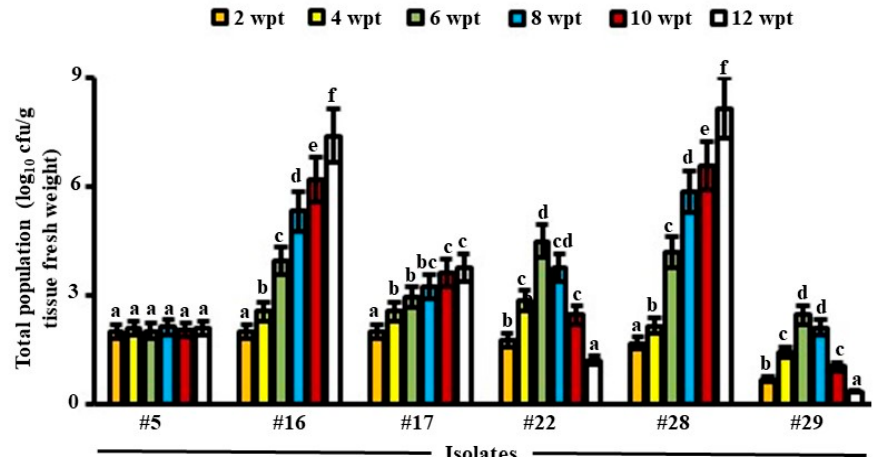
Figure 1. Total population of potential BCAs in date palm roots. The tested endophytic actinobacterial populations in root tissues of date palm grown under greenhouse conditions were sampled at different time points. Values are means of eight replicates ± SE for each sampling from two independent experiments. Mean values followed by different letters are significantly ( p < 0.05) different according to Duncan’s multiple range test. Isolates #16 and #28 represent Streptomyces polychromogenes UAE2 (BCA1) and Streptomyces coeruleoprunus UAE1 (BCA2), respectively. BCA, biological control agent; wpt, weeks post treatment.